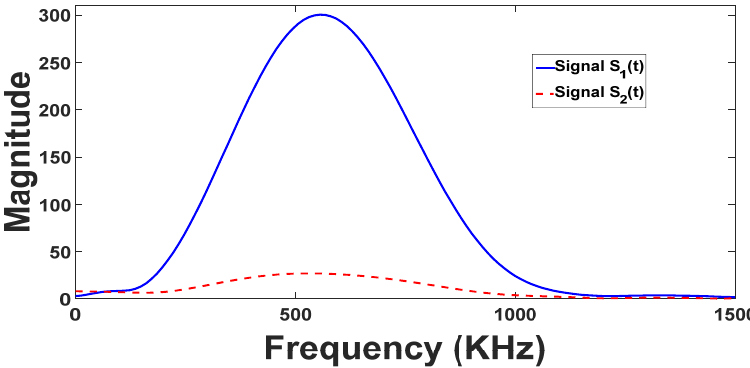
Figure 2. Magnitude spectrum of the cement paste sample ultrasonic results.